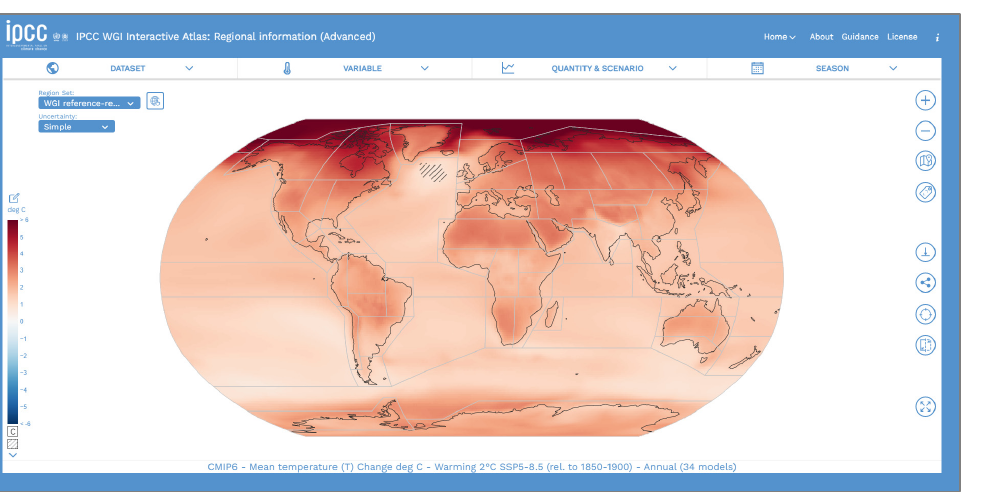
Figure A1. Overview of the resource. Source: Gutiérrez et al. (2021). Questions for reflection and reinforcement of concepts: